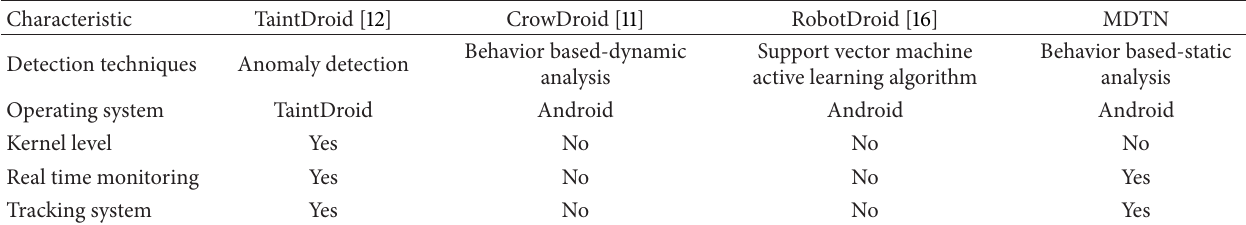
Table 8: Comparison